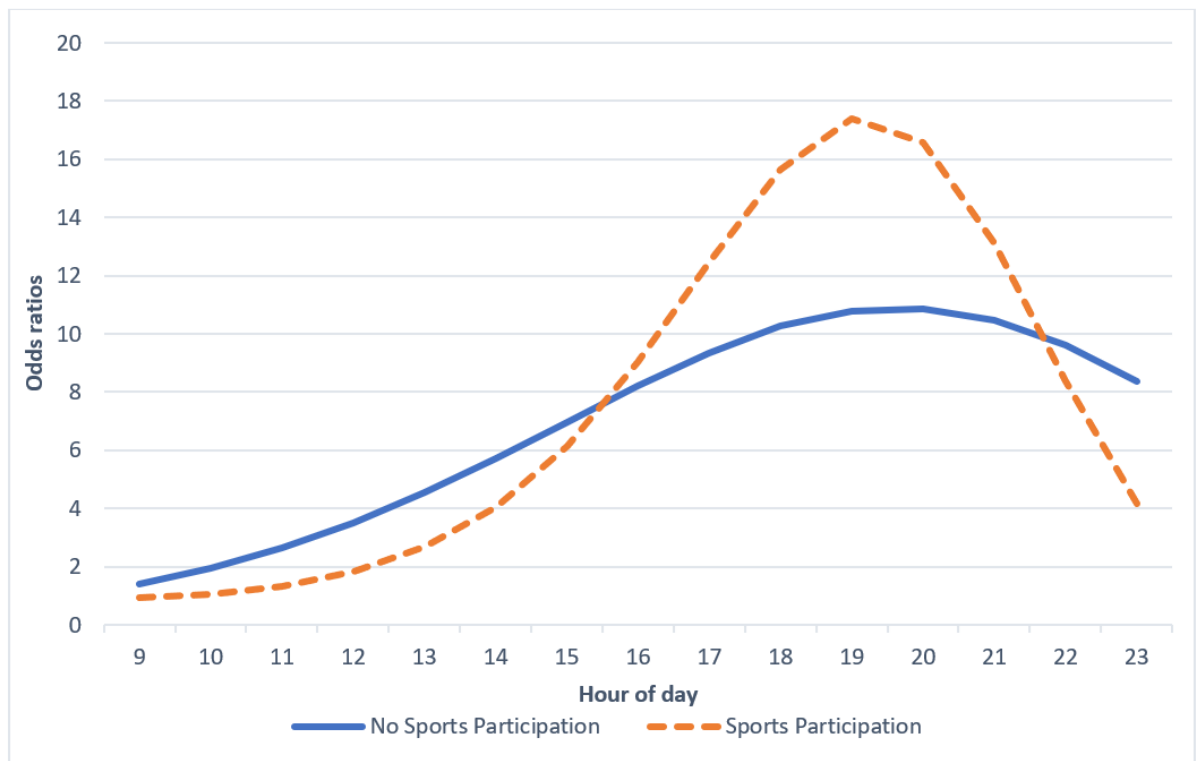
Figure 4. Involvement in organized sports differences in odds ratios of obtaining average moderate-to-vigorous physical activity before each hour of